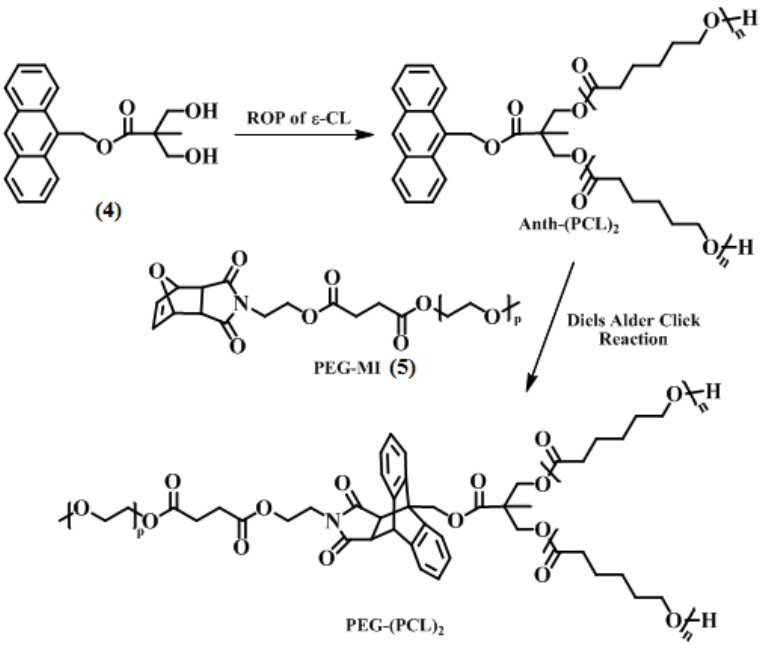
Scheme 2. Synthesis of PEG–(PCL)